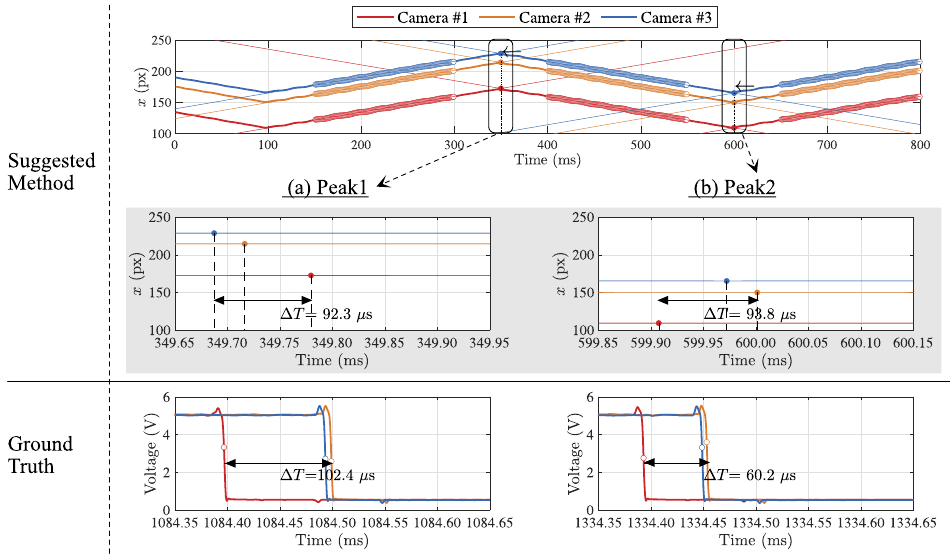
Figure 11. Comparison of the frame synchronization estimations by suggested method to ground truth. Two feature points were detected as the intersections of the regression lines for each camera, and three temporal feature points per each peak position were aligned. The max-min value of them was compared to the ground truth by a logic